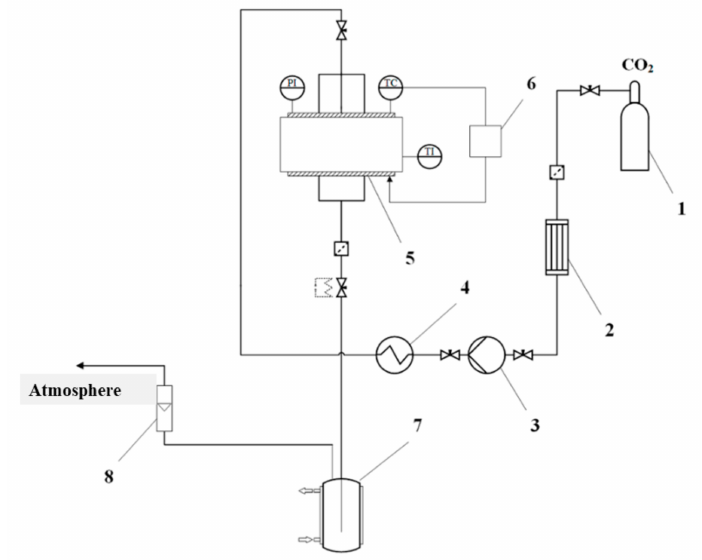
Figure 1. Scheme of the supercritical reactor. 1—CO2 tank, 2—condenser, 3—piston pump, 4—heater, 5—high pressure reactor, 6—thermal control system, 7—separator, 8—rotameter, PI—manometer, TC—temperature probe, TI—temperature